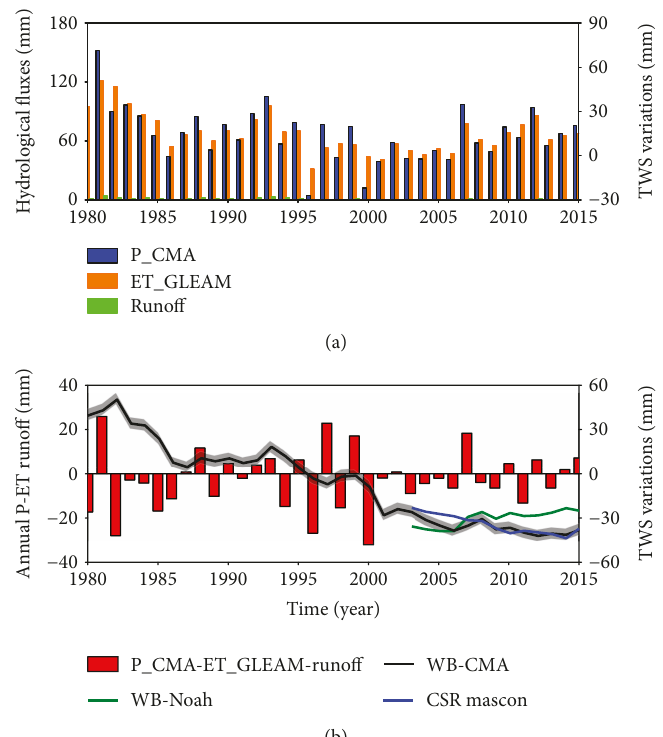
Figure 9: Reconstructed annual TWS variations and related hydrological fl uxes from 1980 to 2015. (a) Change of related hydrological fl uxes with time; (b) change of TWS variations and related hydrological fl uxes di ff erence with time. The shadows represent the uncertainties in reconstructed